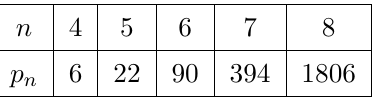
Table 3 . Number of non-empty positive regions p n for 4 ≤ n ≤ 8